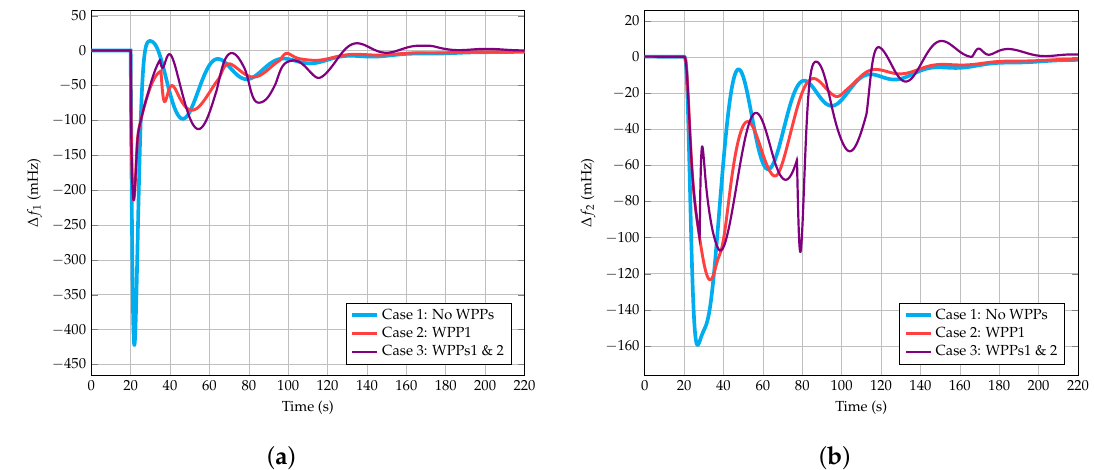
Figure 8. Area 1 under power imbalance ( ∆ P L ,1 ); ( a ) frequency oscillations in Area 1; ( b ) frequency oscillations in Area